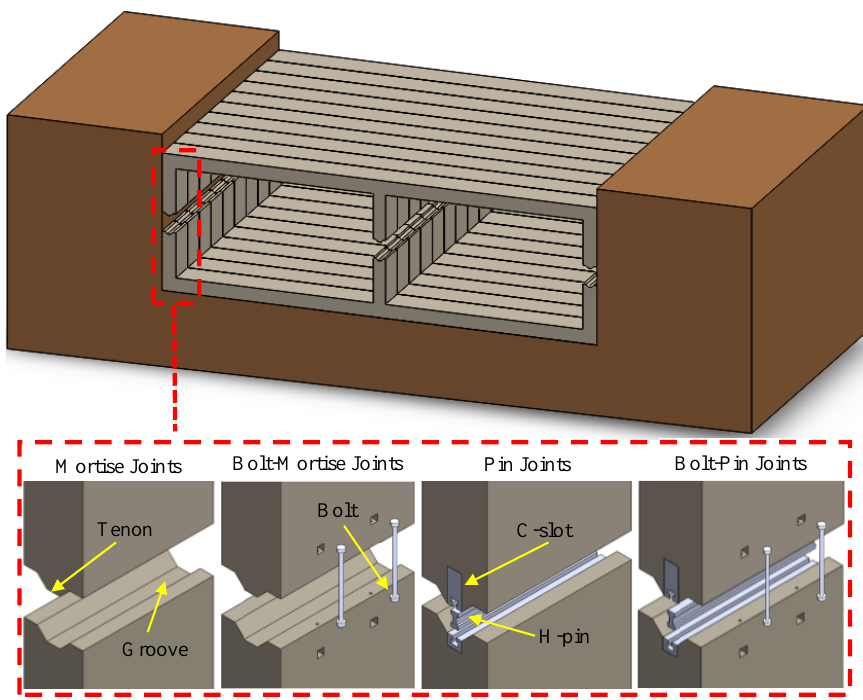
Figure 1. Fabricated frame tunnel joints.